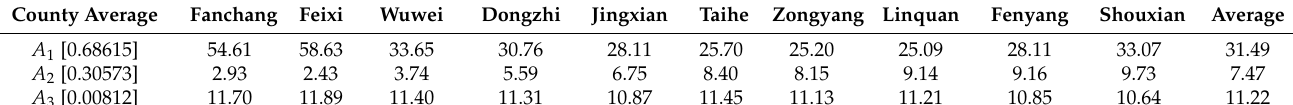
Table 4. Actual progress of sewage treatment in 10 sample counties. Units: %.